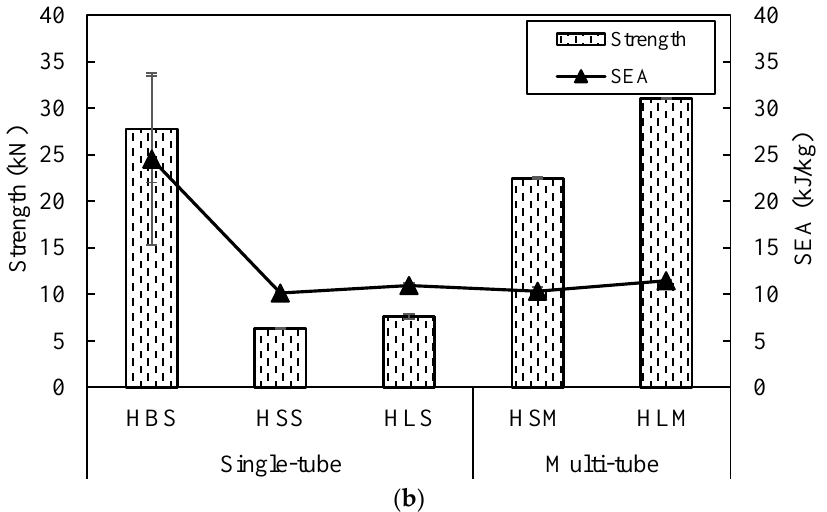
Figure 13. Compressive strength and SEA for single and multiple tube embedded in ( a ) F50 and ( b ) HP80 foams.